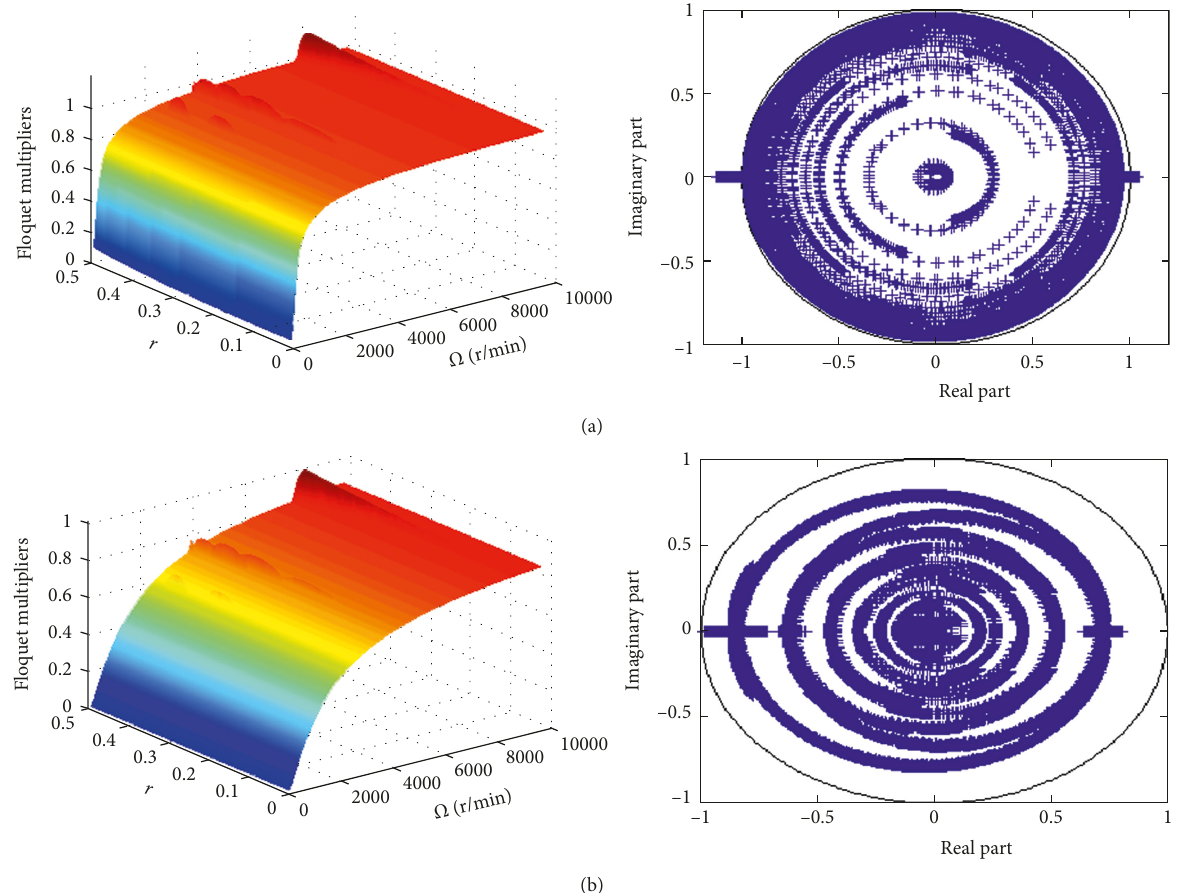
Figure 20: Maximum Floquet multipliers versus crack depth ratio and rotation speed and Floquet multipliers on the complex plane for (a) ζ � 0.01 and (b) ζ �